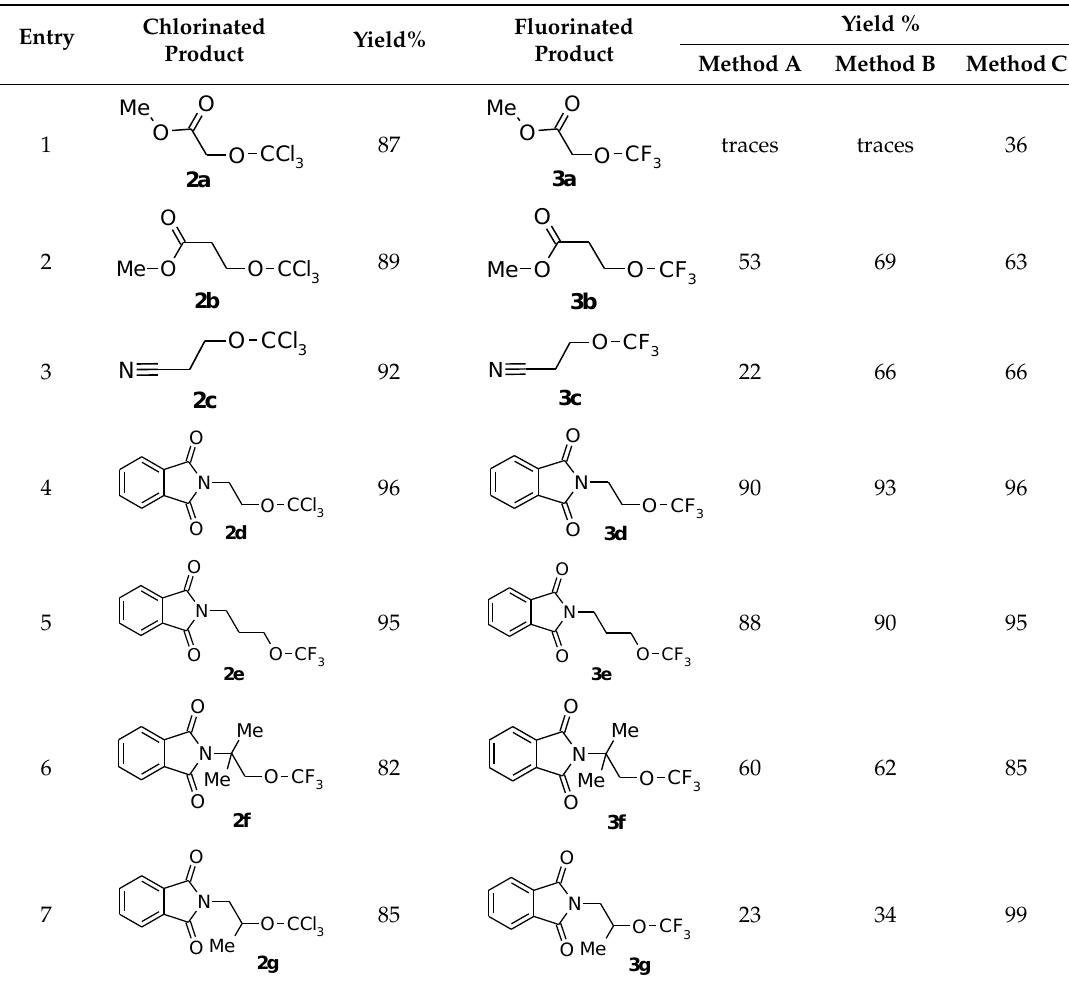
Table 1. Structures and yields of chlorinated and fluorinated products.